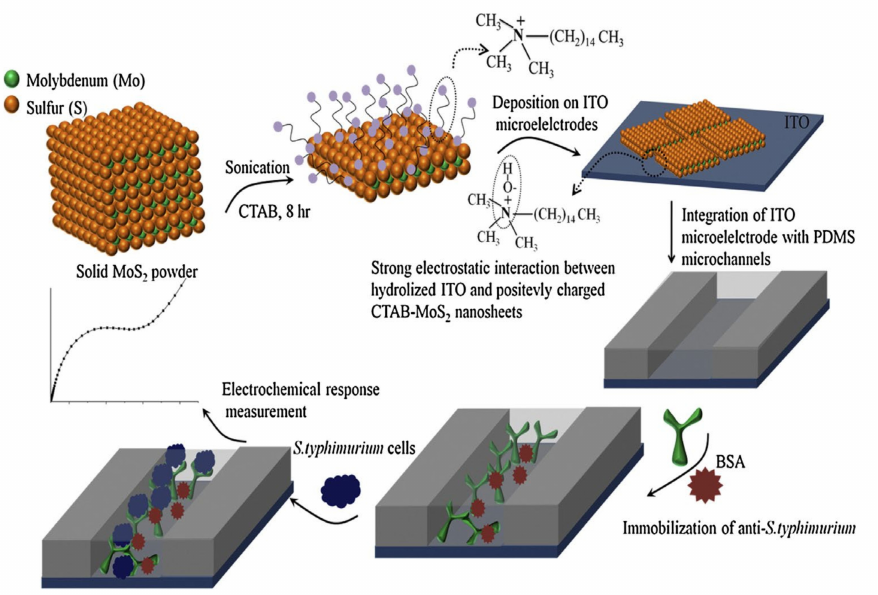
Figure 11. Design of a MoS 2 based biosensor for S. typhimurium detection. Adapted with permission from [145] Copyright 2018,